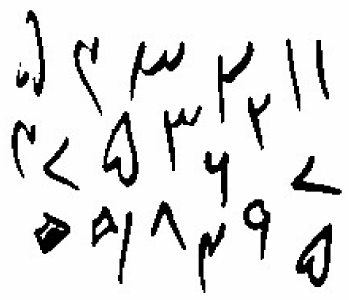
Figure 8. Ideal threshold